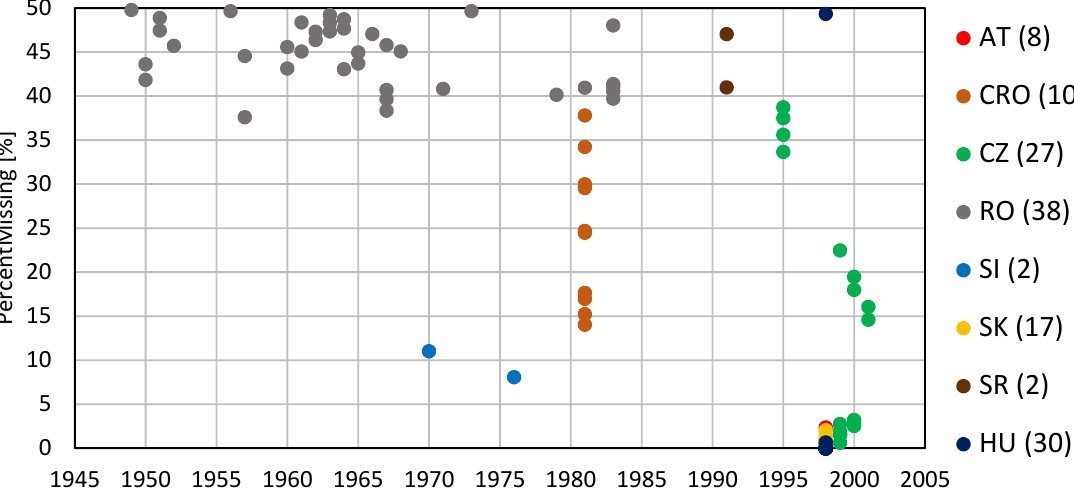
Figure 2. Data availability for this study by country.